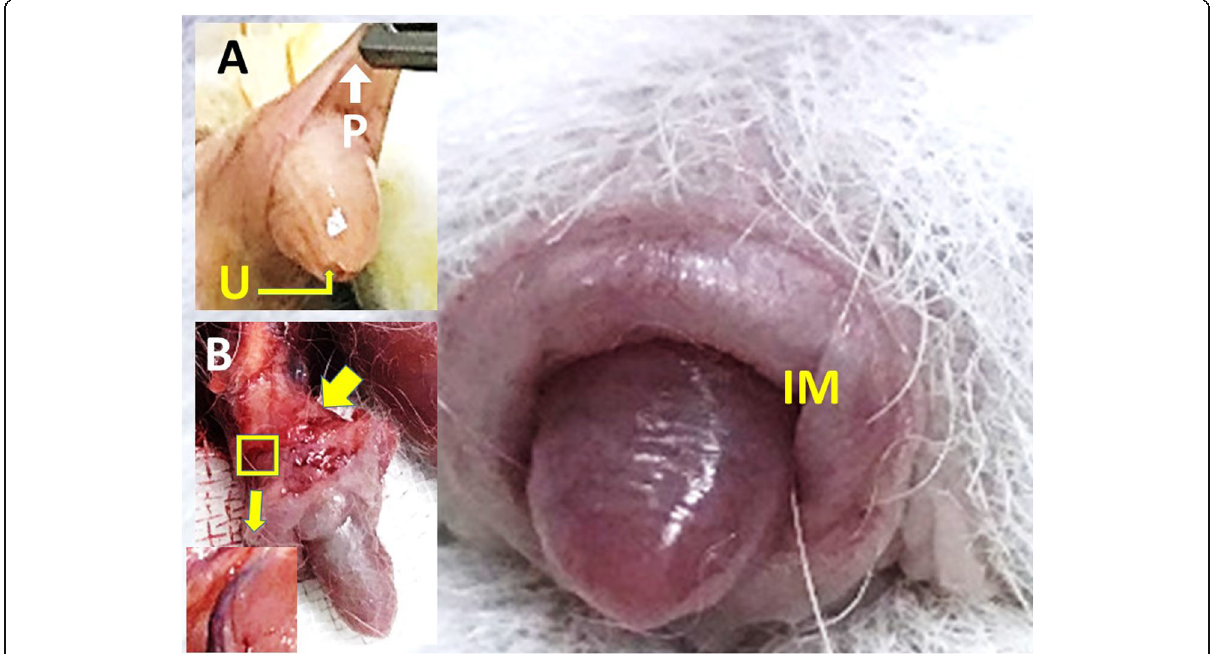
Fig. 4 a Appearance of the penis, urethral mea (U) and preputium (P) in a normal rabbit; the penis and preputial tissue (IM) 3 weeks after circumcision (base). b The dissected view of the partially healing oedematous penile-peripenile soft tissues (yellow arrow) and dorsal penile